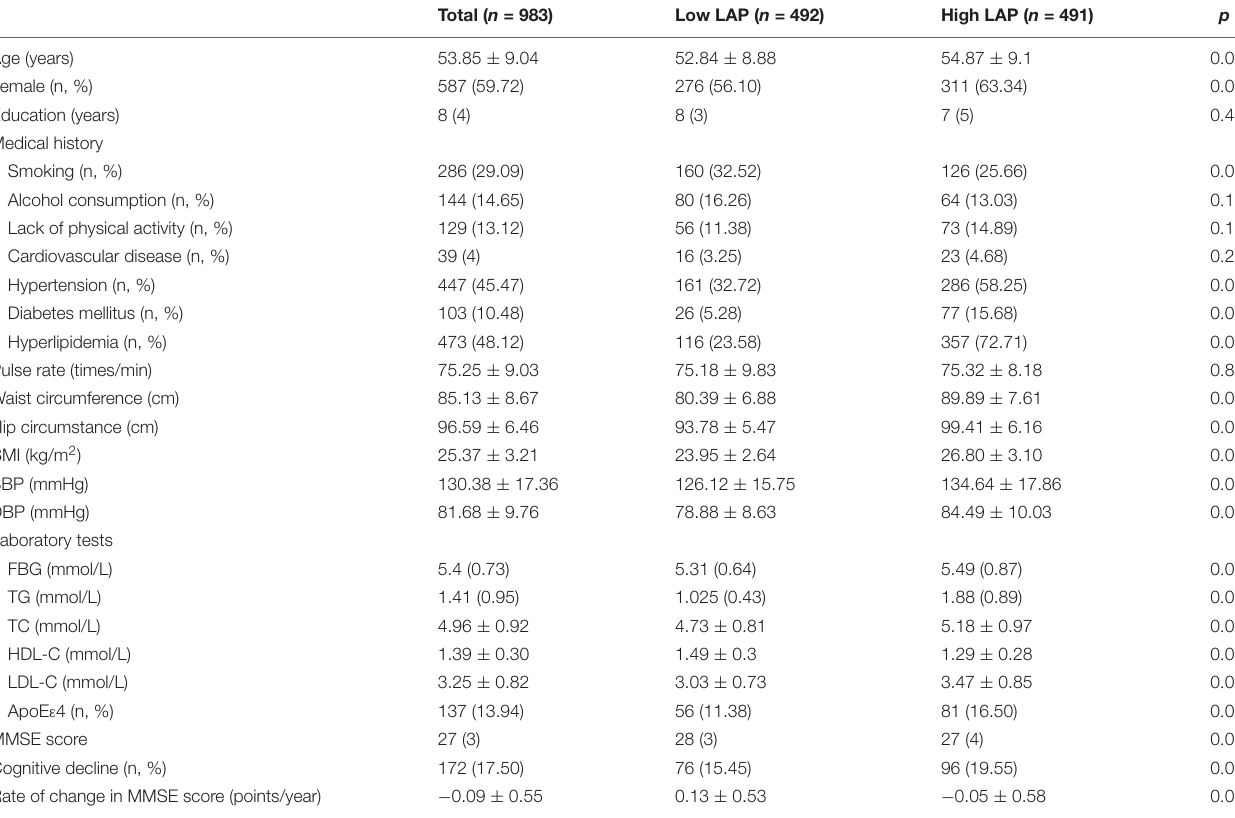
TABLE 1 | Characteristics of the